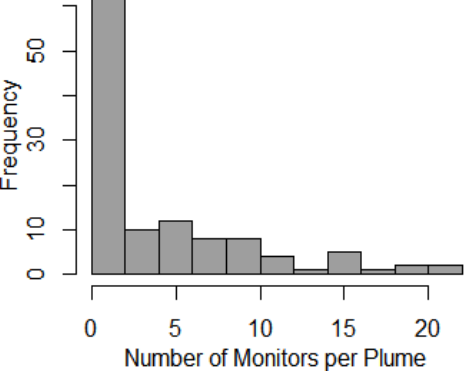
Figure 2. Frequency distribution of plumes for prescribed and wildfires by month ( a , b ) and year ( c , d ).